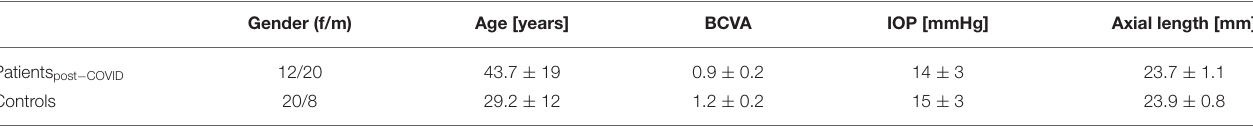
TABLE 1 | Demographic data of the prospective study cohort for long-term effects of coronavirus disease 2019 (COVID-19) infection: gender, age, best-corrected visual acuity (BCVA), intraocular pressure (IOP), and axial length in patients after COVID-19 infection (patients post − COVID ) and